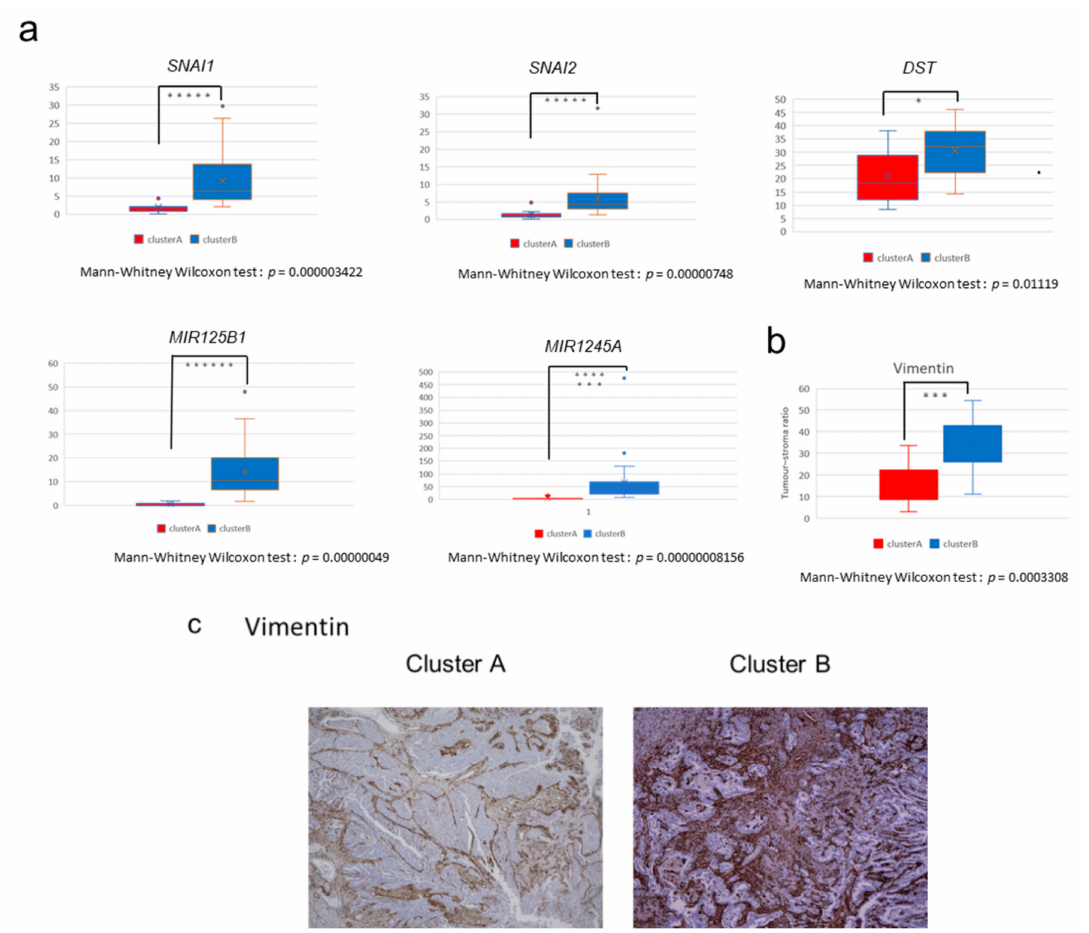
Figure 3. Expression of stroma-related genes in GBCs. ( a ) Comparison of the expression of stroma-related genes ( SNAI1 , SNAI2 , DST , miRNA125b1 , and miRNA1245A ) between the two clusters in fragments per kilobase of exon per million fragments mapped (FPKM; Mann–Whitney Wilcoxon test, p < 0.05). The y -axis shows FPKM of each gene. When p < 0.05, the asterisk increases with each zero digit; for example, *** for p < 0.0001. ( b ) Vimentin immunostaining. Ratio of the area of the positive cells/tumor cells was used to calculate stromal ratio in tumors ( p = 0.0003308 by Mann–Whitney U test). ( c ) Vimentin immunostaining in the representative GBC tissues in Cluster A (left) and Cluster B (right). Positive cells are brown in color. Each sample was observed with a 4 × objective